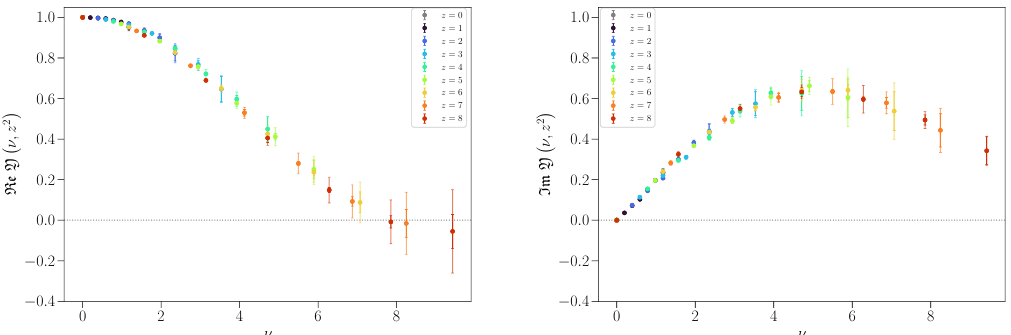
(cid:0) (cid:1) ν, z 2